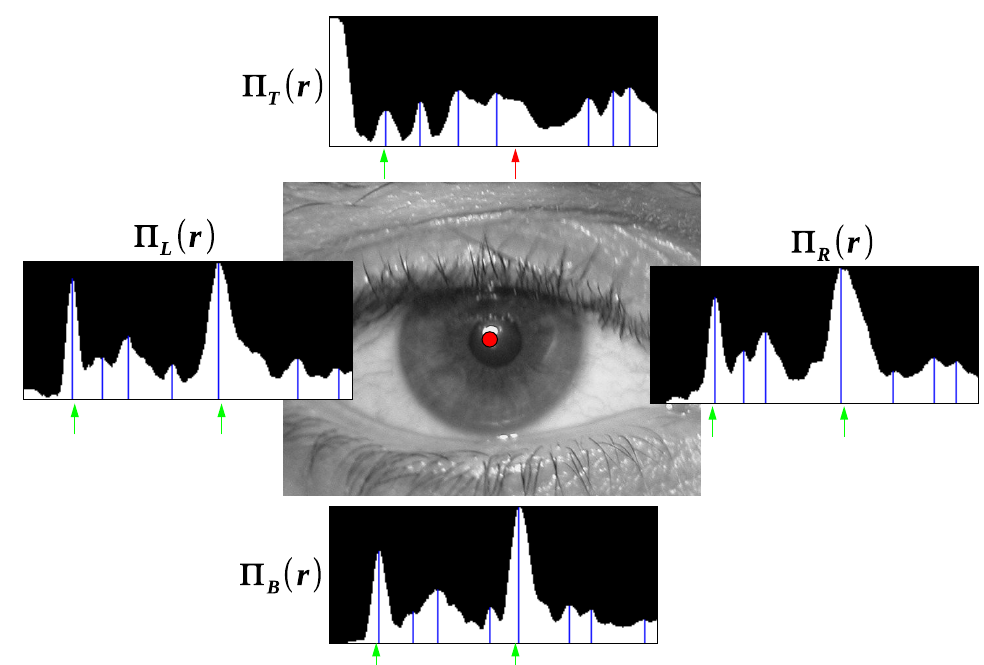
Figure 3. Four circular projections, their maxima positions and correct position of